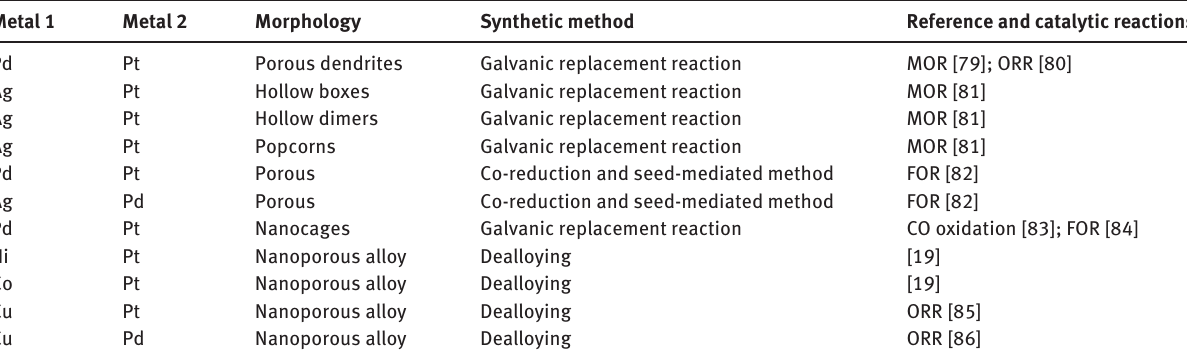
Table 3 List of porous/hollow Pt- and Pd-based bimetallic nanostructures, their synthetic methods, and catalytic reactions. Metal